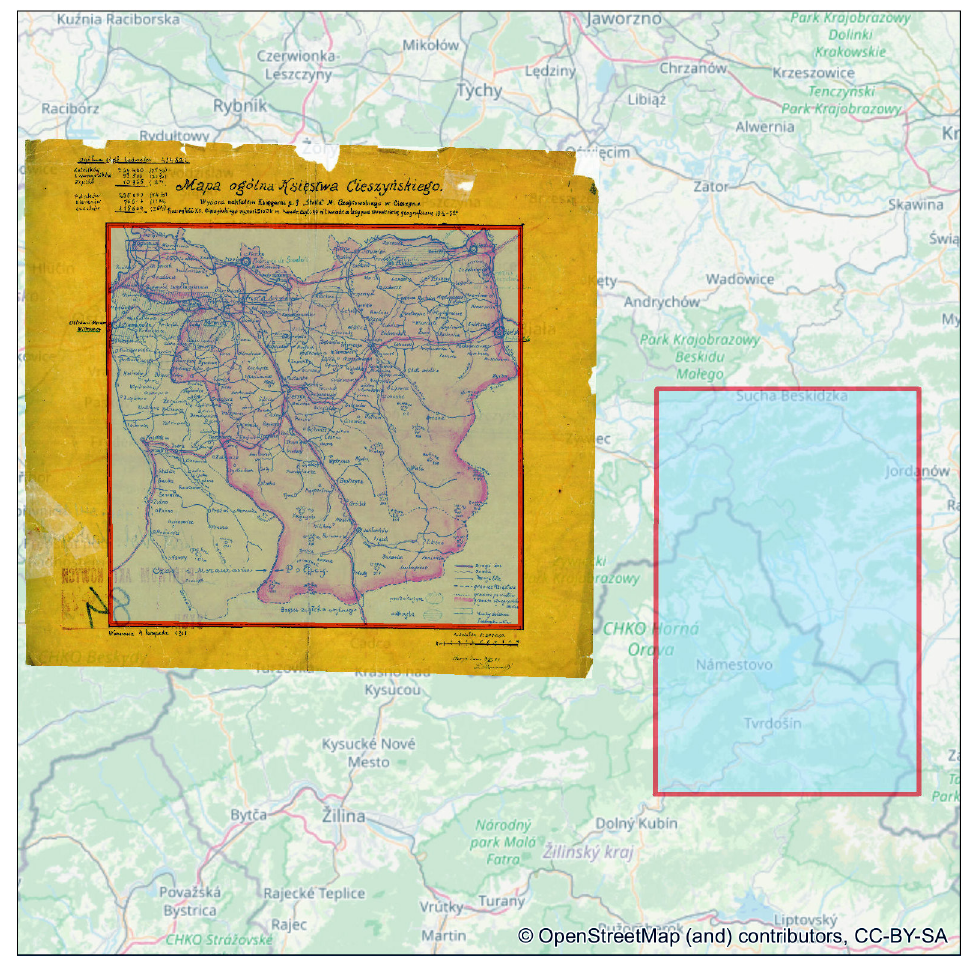
Fig. 3. Example of spatial metadata − extents of selected maps (author’s